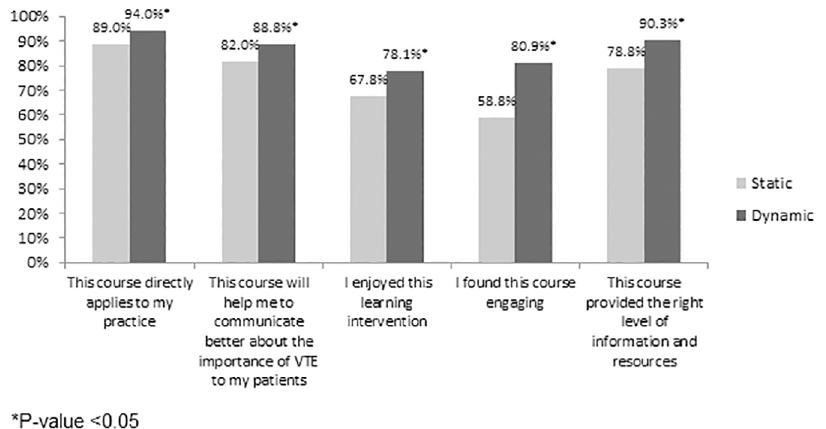
Fig 2. Nurse-reported satisfaction with and perception of Dynamic education module and the Static education module across five domains of engagement among nurses who completed their assigned education